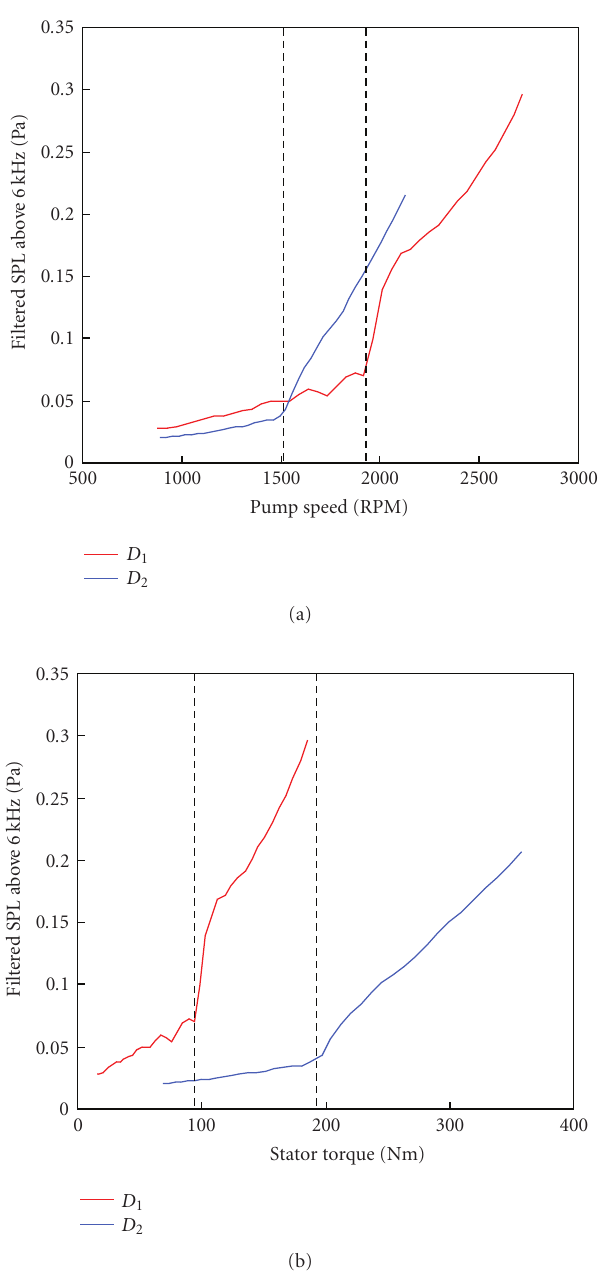
Figure 5: (a) Filtered SPL versus pump speed and (b) stator torque for stall speed sweep of 40RPM/s at p c = 791 kPa, p b = 584 kPa, and θ in = 70 ◦ C. Vertical dashed lines indicate onset of cavitation.